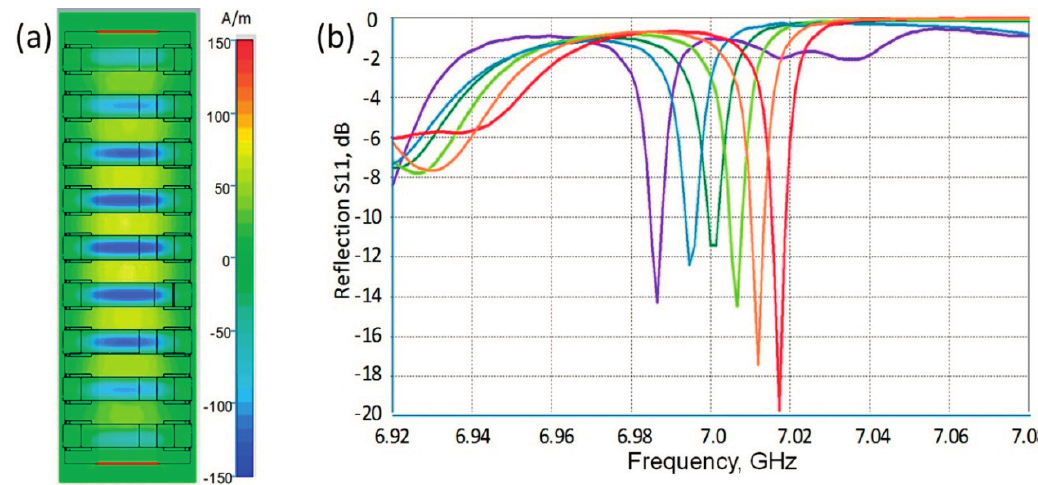
Figure 11. ( a ) Simulated field pattern in the cross-section of the sensor presented in Figure 10 confirming the formation of sin-phase Fano-type resonances in the DR array; ( b ) shifts of resonance related S 11 dips (from red to violet) at changing the analyte relative permittivity from 1 to 3 by equal steps.